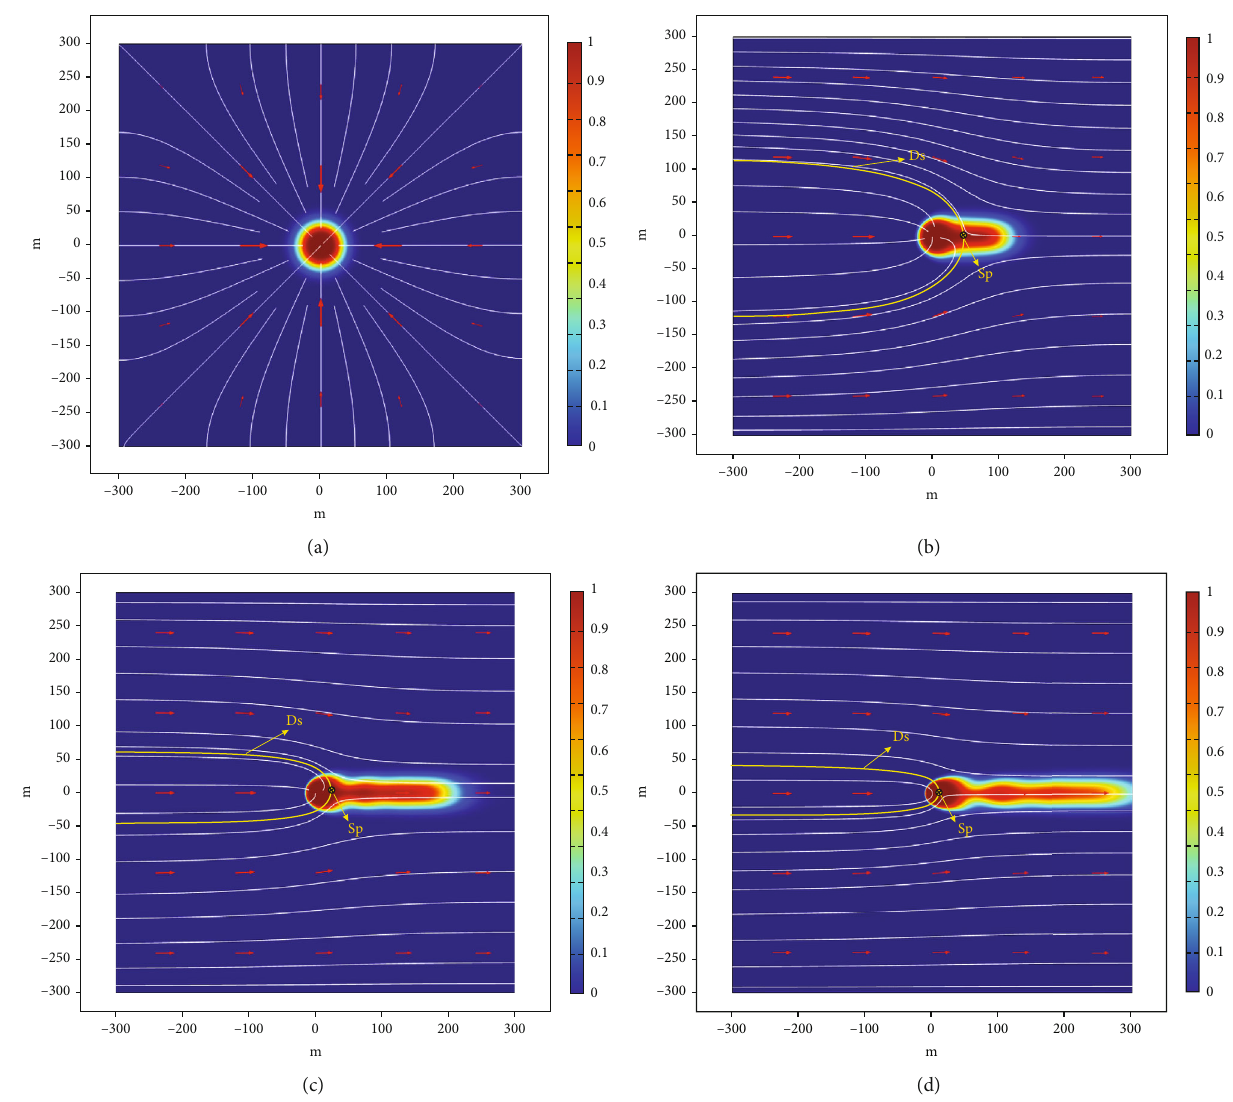
Figure 6: Concentration distributions in a 2D horizontal plane at t v = 1 : 5 × 10 − 6 d